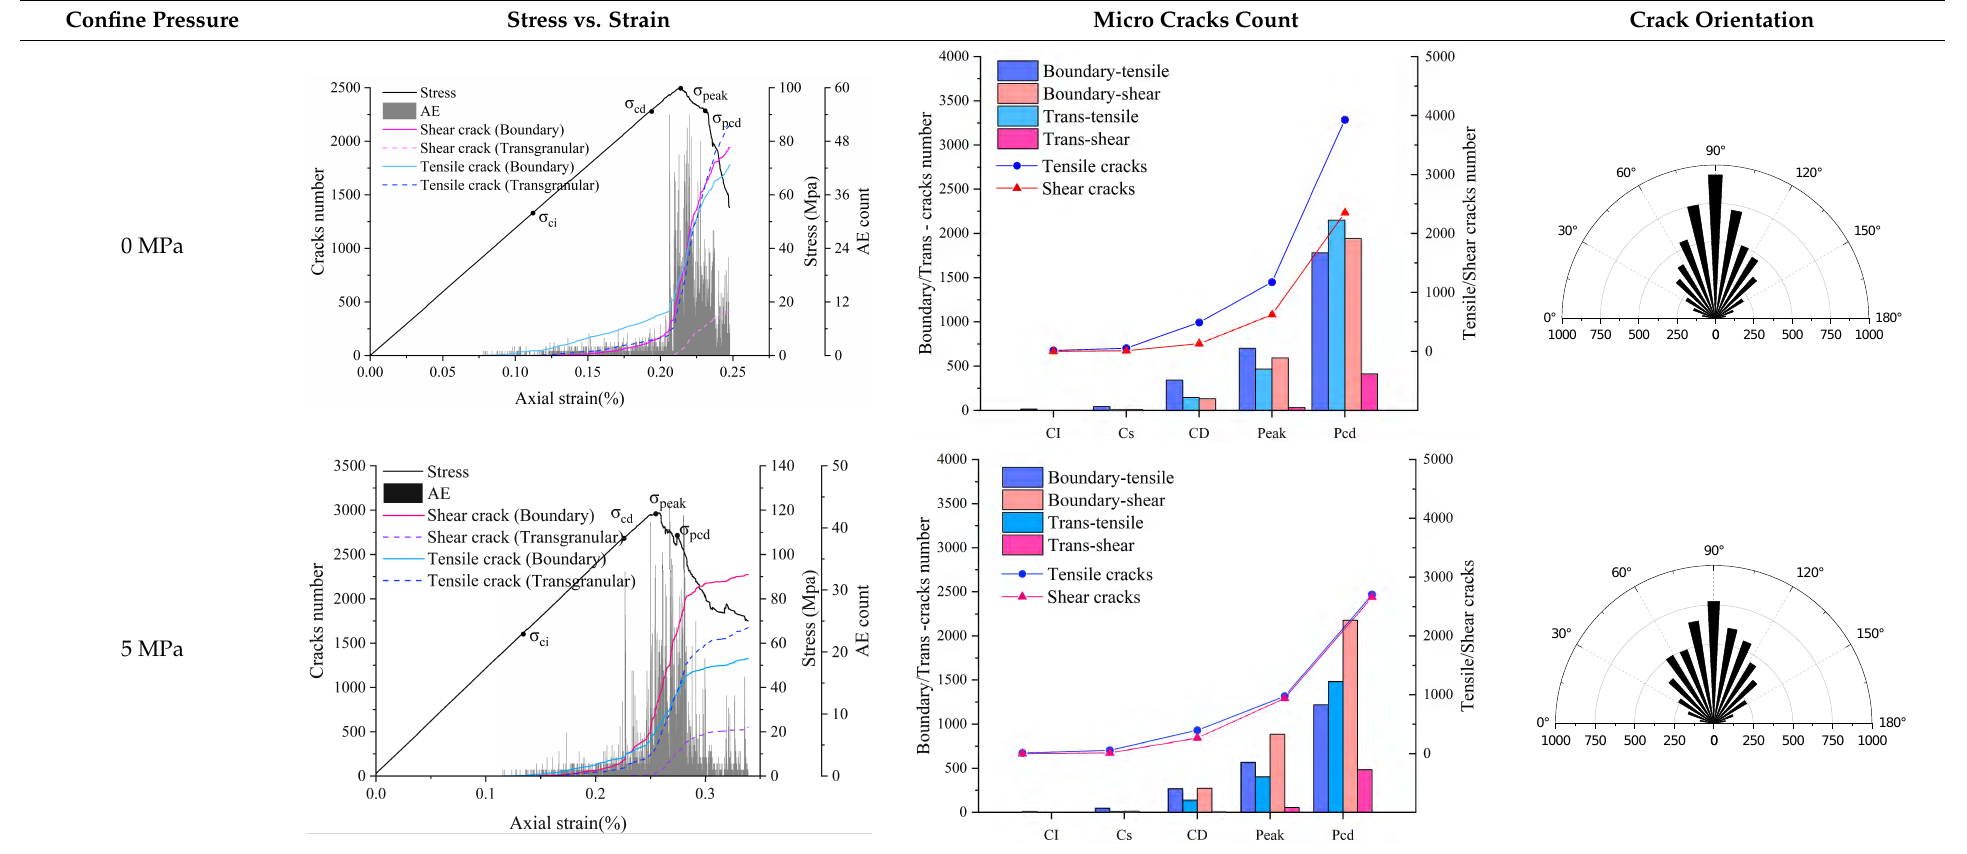
Table 5. Analysis of numerical simulation results: Comparison of granite microcracks under differ- ent confining pressure conditions (0–20 MPa). Note: ‘Cs’ in crack statistics represents the occurrence of shear